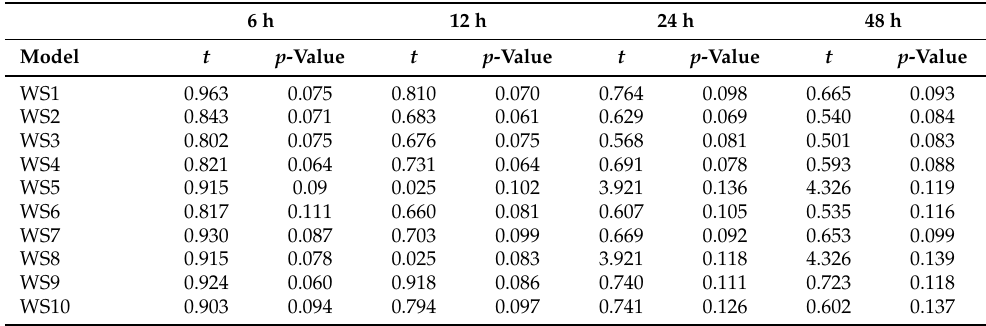
Table 6. t -test for comparing our model forecast results from experimental site with weather stations. 6 h 12 h 24 h 48 h